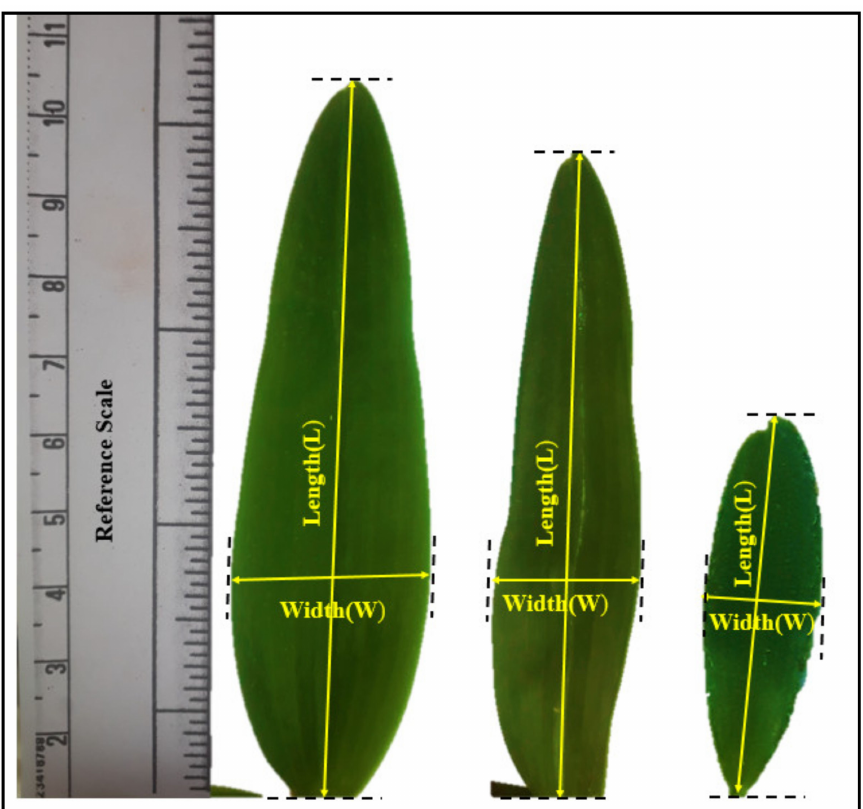
Figure 2. Images of individual leaf of D. nobile captured through smartphone with a reference scale for measurement of leaf length (L) and leaf width